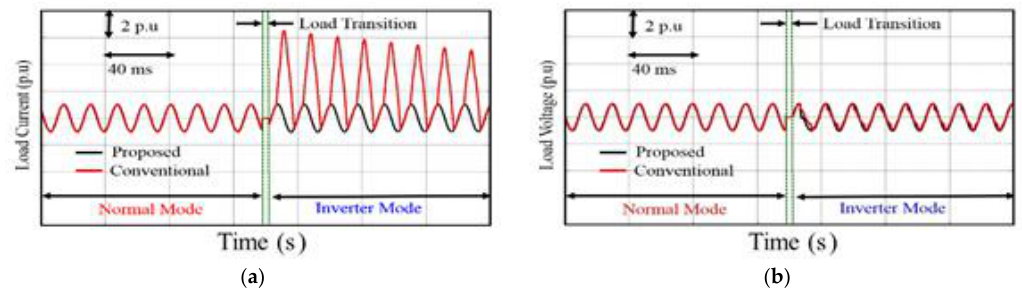
Figure 23. ( a ) Load current; and ( b ) load voltage for the conventional and proposed single-phase offline UPS topologies when the inverter voltage is injected at 330°.